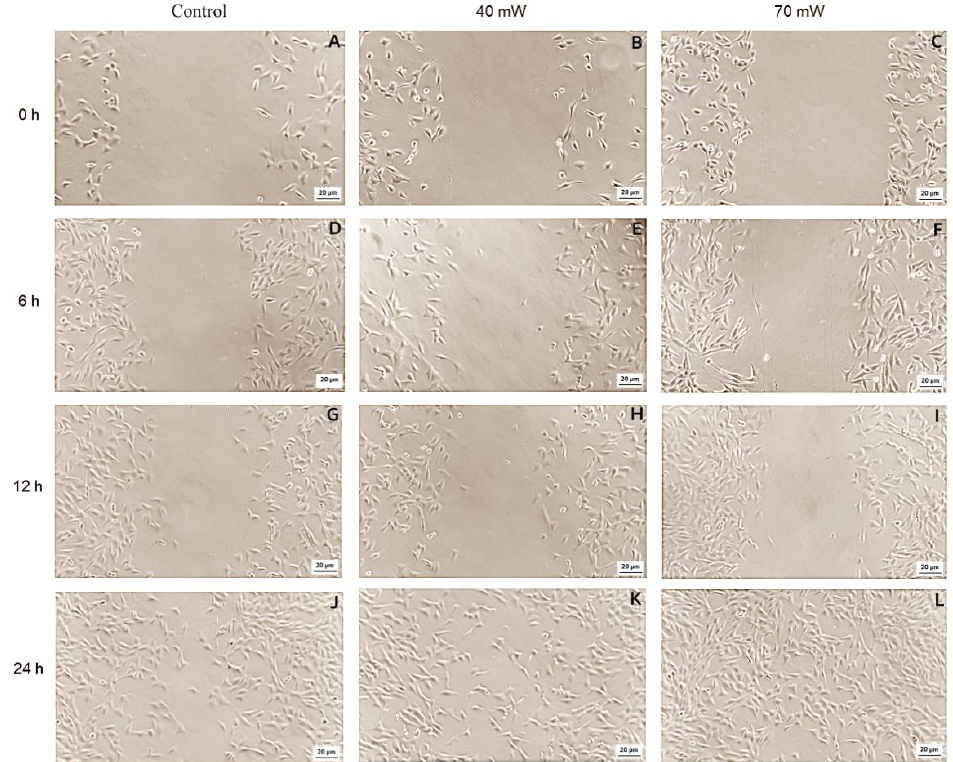
Figure 5. Wound area closure ( A ) 6 h, ( B ) 12 h, and ( C ) 24 h after to perform scratch wounds and the irradiation with LLL(ANOVA/Tukey); * p < 0.05 vs. control ** p < 0.01 vs. control .